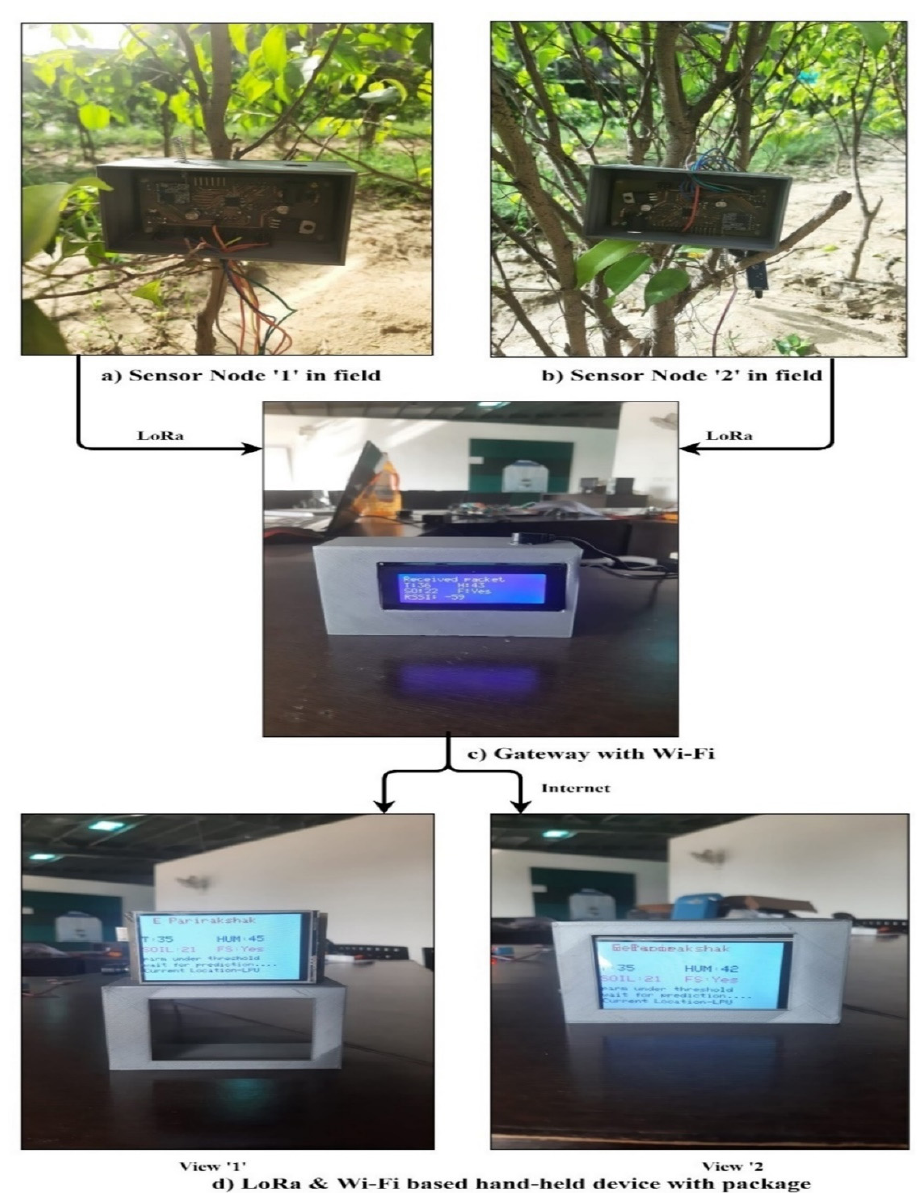
Figure 16. Real-time experimental setup of the sensor node and gateway.